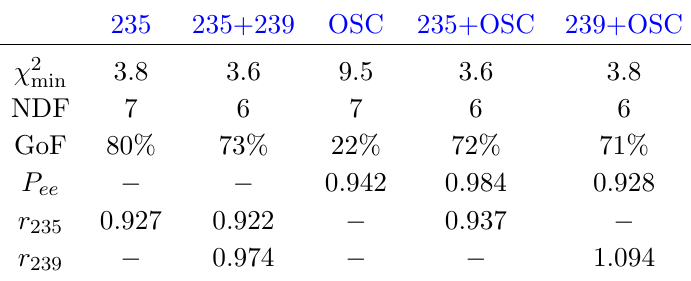
Table 1 . Fits of the Daya Bay evolution data [11].